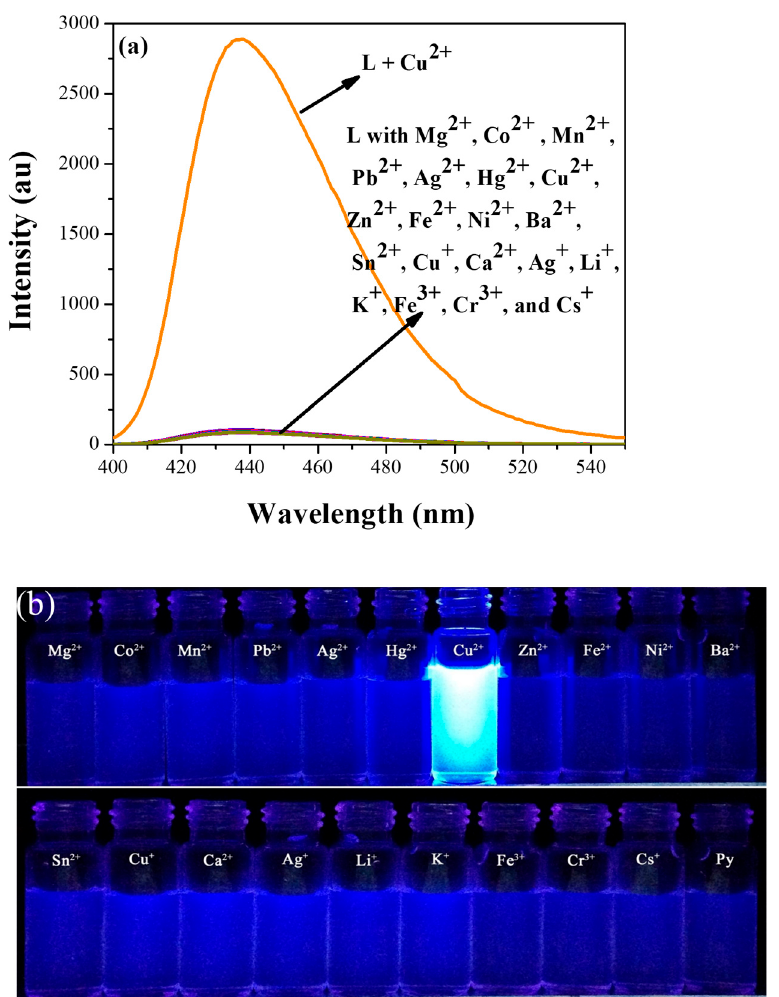
Figure 3. ( a ) Fluorescence changes of L (10 µM) in ethanol–water ( v / v = 7/3, 5 mM HEPES, pH 7.0) in the presence of Cu 2+ (5 µM) with various metal ions (15 µM) at λ ex = 380 nm with excitation slit = 5 nm and emission slit = 5 nm. ( b ) Fluorescence emission photographs of L (10 µM) with various metal ions (15 µM) in ethanol–water ( v / v = 7/3, 5 mM HEPES, pH 7.0).